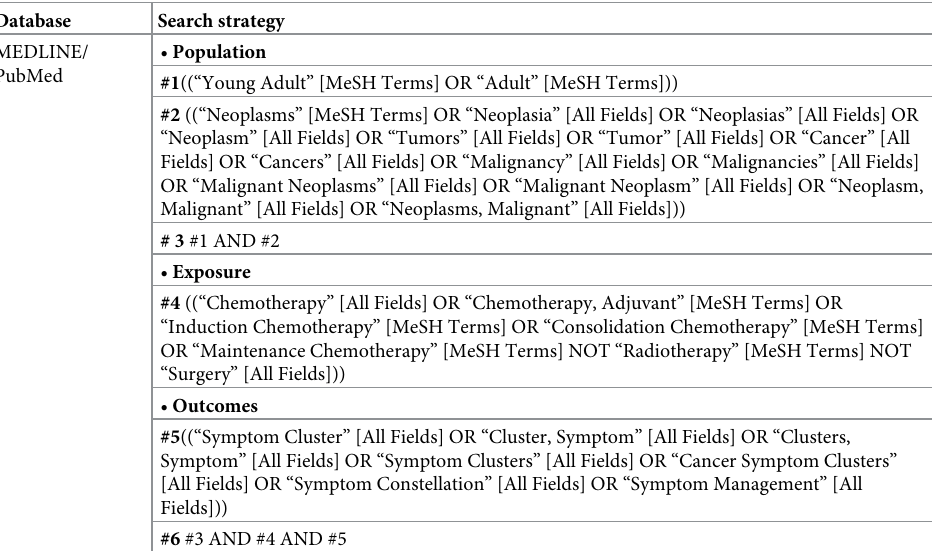
Table 1. Preliminary pilot search strategy in